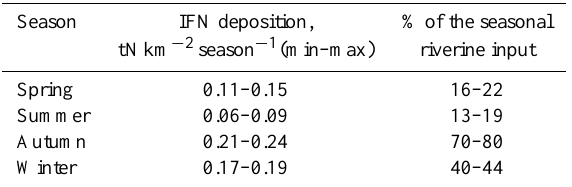
Table 2. Seasonal variations in deposition of IFN at the Black Sea